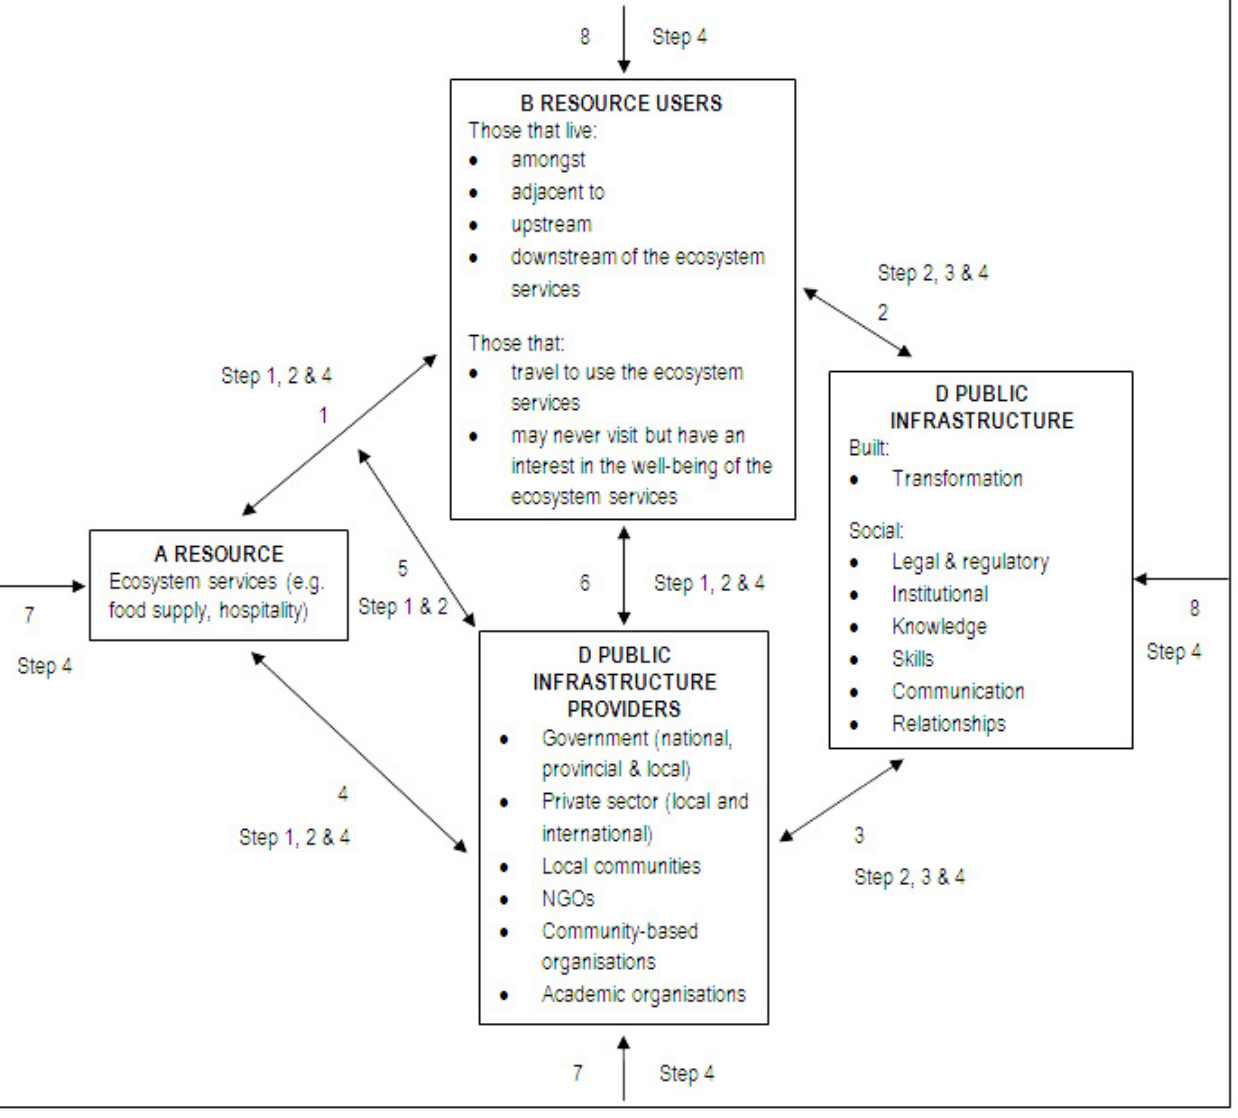
Fig. 1 . Adaptation of the Anderies et al. (2004) conceptual social-ecological system framework showing (i) examples of how it relates to an estuarine system as presented in R. Bowd, N. W. Quinn, D. C. Kotze, D. G. Hay, and M. Mander ( unpublished manuscript ); and (ii) how the toolkit links with the Anderies et al. (2004) framework in which Step 1 - ecosystem services supply and demand assessment; Step 2 - future estuary roles identification; Step 3 - enterprise opportunity identification; Step 4 - enterprise risk